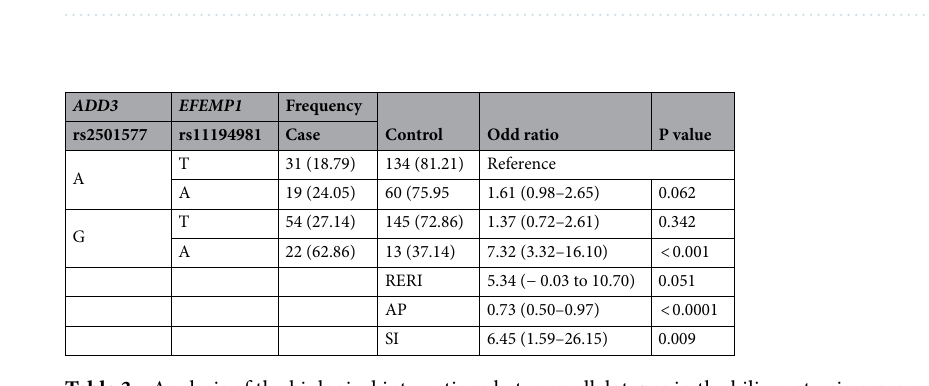
Table 2. Statistical analysis of single nucleotide polymorphisms in ADD3 and EFEMP1 among biliary atresia cases and controls.